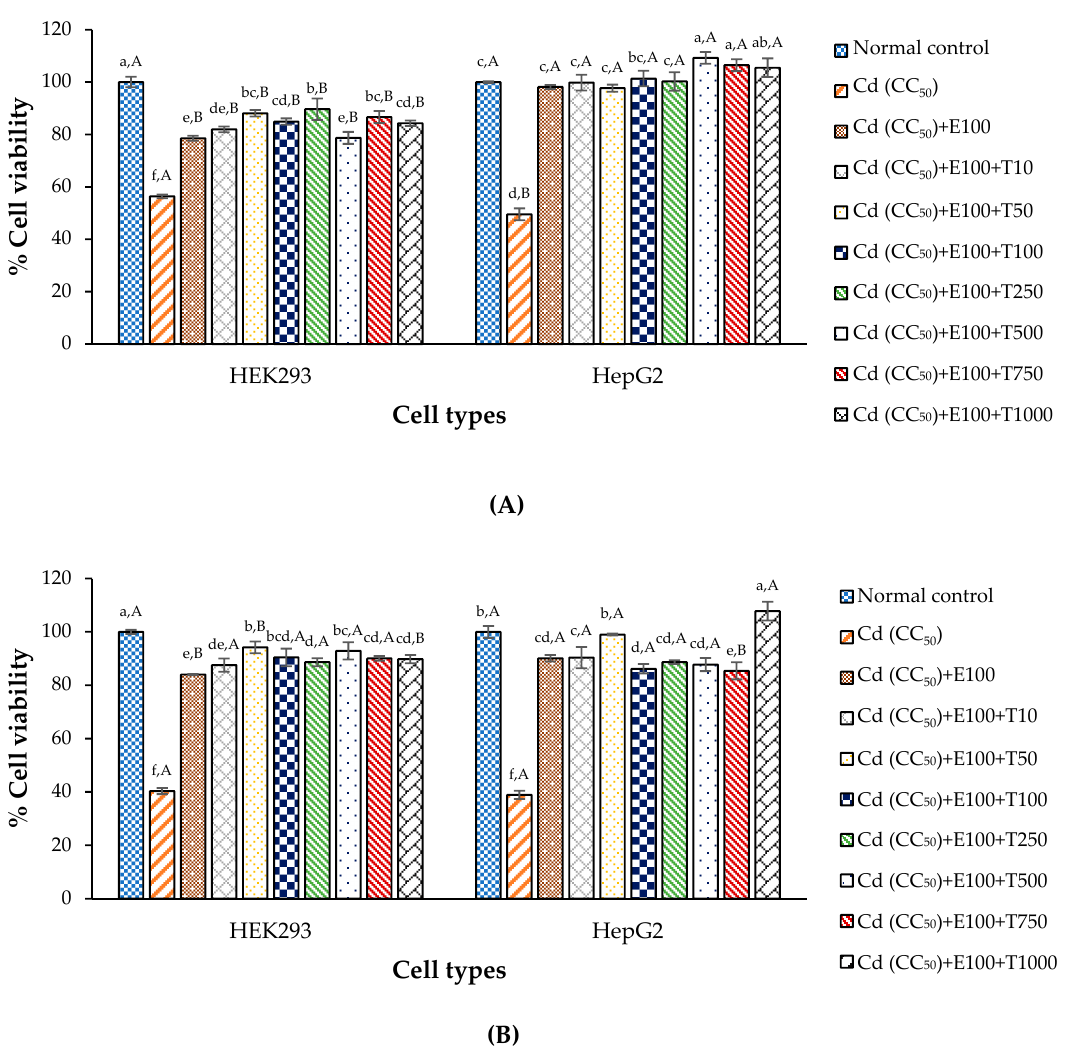
Figure 5. Anti-Cd toxicity of the CDE of T. laurifolia leaves coupled with CaNa 2 EDTA based on cell viability in HEK293 and HepG2 cells determined by MTT assay; ( A ) pre-treatment and ( B ) post-treatment; a–f means within a figure with di ff erent letters are significantly di ff erent ( p < 0.05); A,B means within an extract concentration with di ff erent letters are significantly di ff erent ( p < 0.05); T means the CDE of T. laurifolia leaves ( µ g / mL) and E means CaNa 2 EDTA at 100 µ g / mL; Values are mean ± standard deviation.